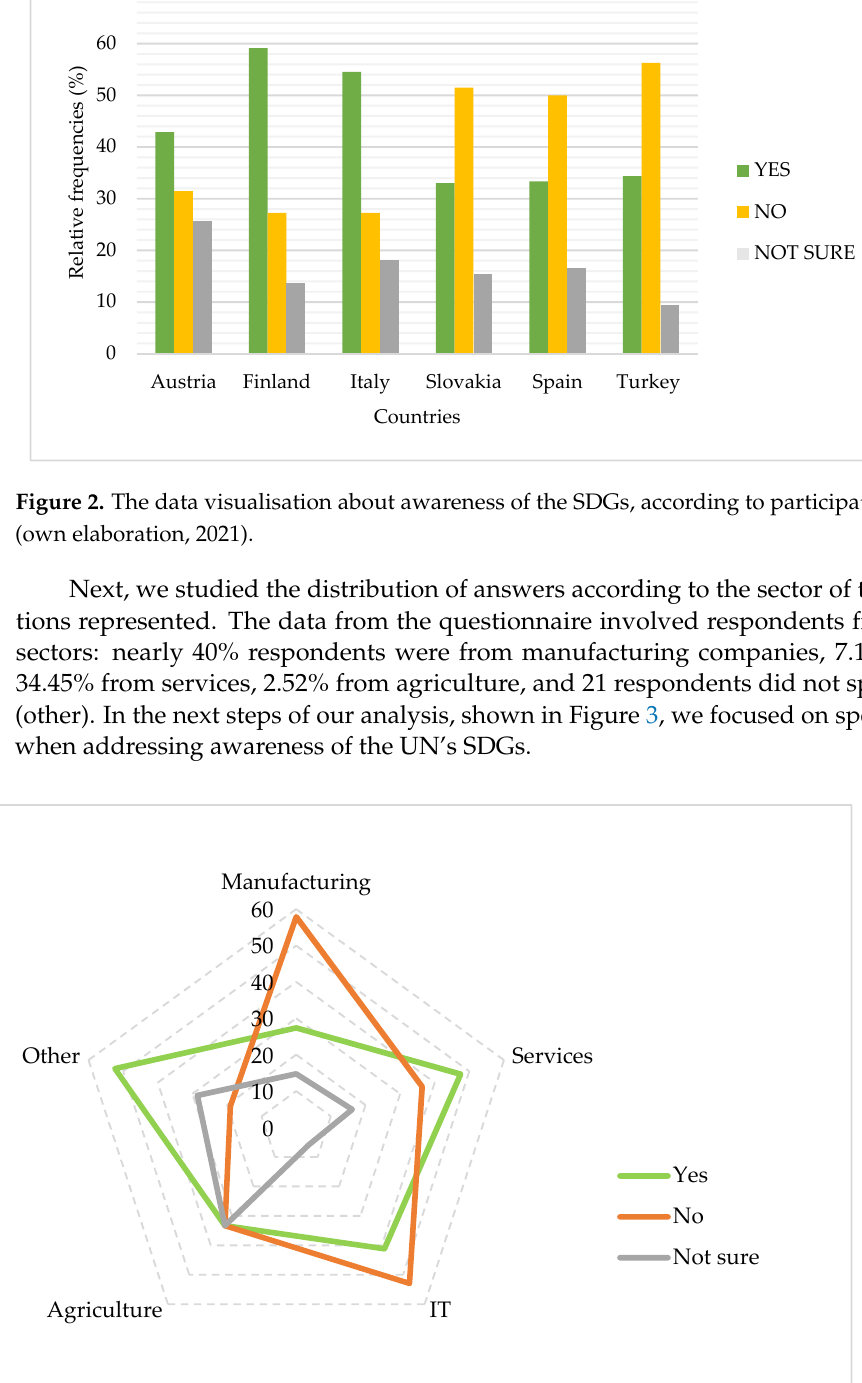
Figure 3. The data visualisation about awareness of the SDGs, according to a sector of the employer (own elaboration, 2021).